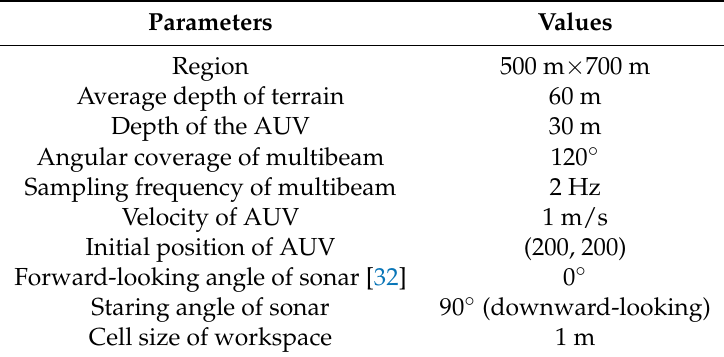
Table 1. Setup of the simulation model.